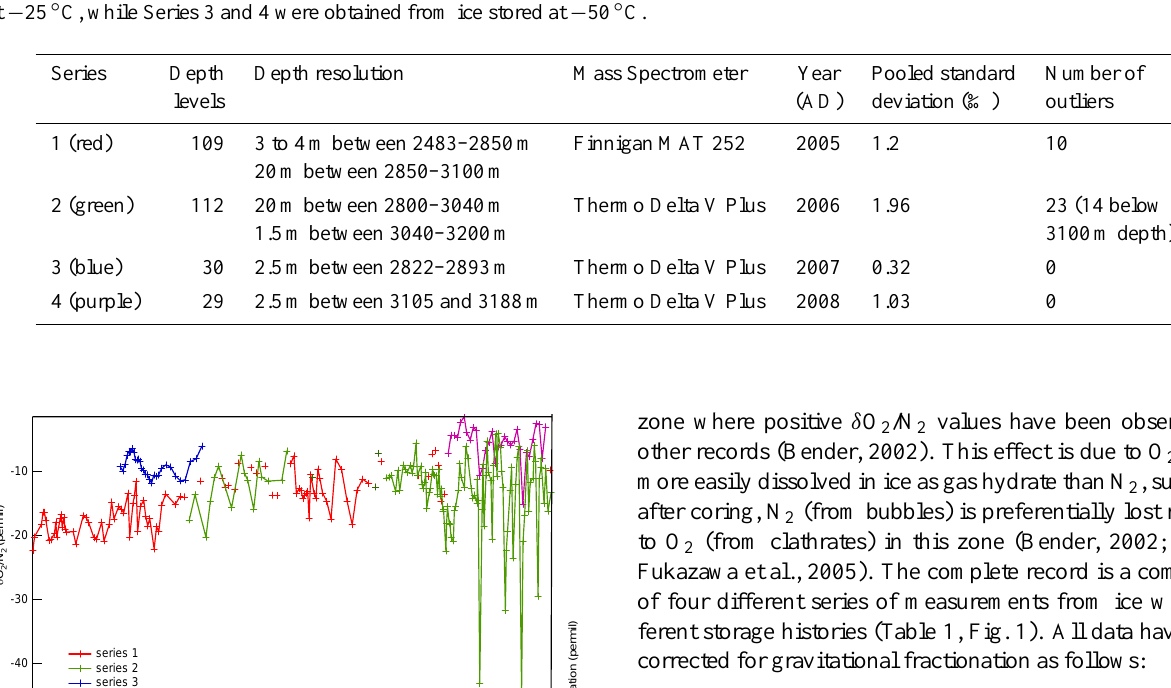
Table 1. Details of the 4 different series of δ O 2 /N 2 data measured at LSCE (Laboratoire des Sciences du Climat et de l’Environnement) on the EDC ice core (see also Fig. 1). We indicate the number of the series as referenced in the text, the number of depth levels studied, the mean depth interval, the mass spectrometer on which the δ O 2 /N 2 measurements were carried out, the year when the analyses were performed, the pooled standard deviation, and the numbers of depth levels rejected associated with each series. Series 1 and 2 were obtained from ice stored at − 25 ◦ C, while Series 3 and 4 were obtained from ice stored at − 50 ◦ C.